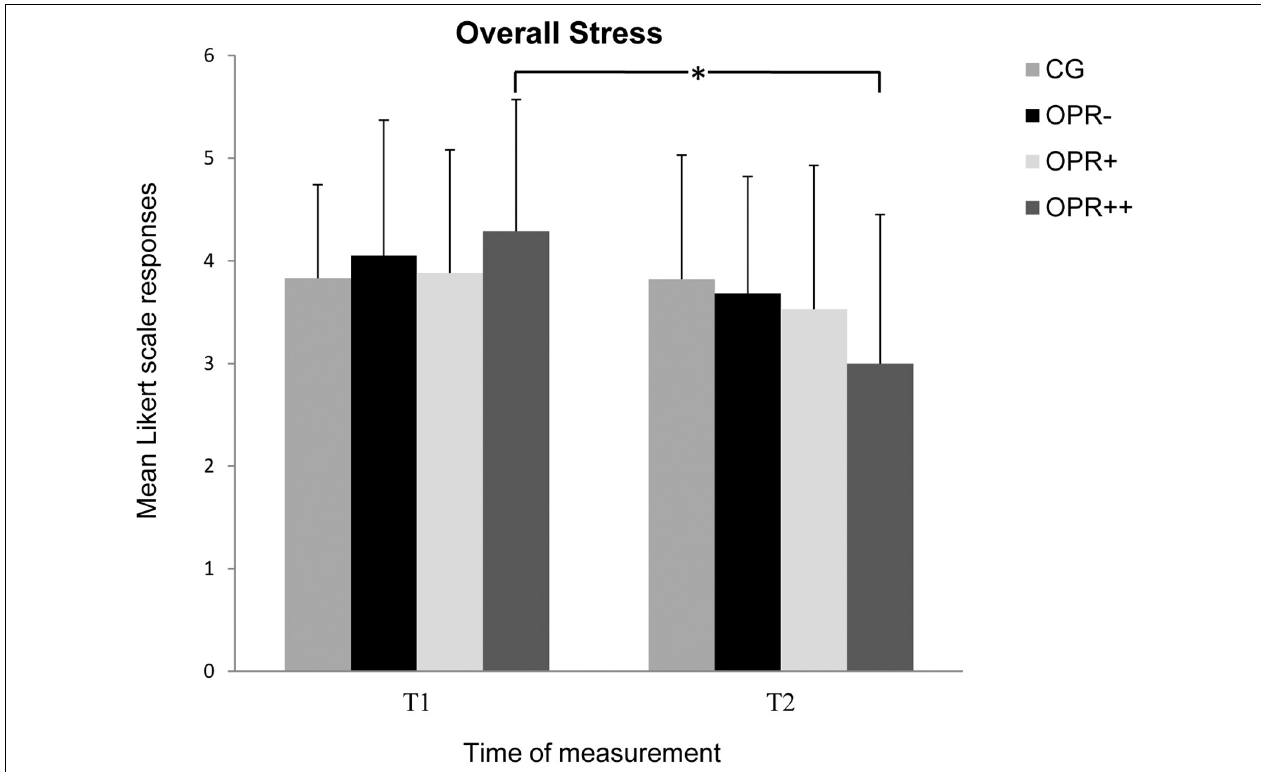
FIGURE 7 | The mean values of the Overall Stress of the groups as a function of the time of measurement (T1, T2). The symbols represent across-participant means, and error bars show standard deviations. The 7-point Likert scale ranged from “does not apply at all” (0) to “fully applies” (6). (CG: control group without any intervention; OPR - group: got a filled bottle of water every day without any label on it; OPR + group: got a filled bottle of water every day with the label “Imagine I Am Health”; OPR ++ group: got a filled bottle of water every day with the label “Imagine I Am Health” and an audio file with a health mediation) ( *p < 0.013).